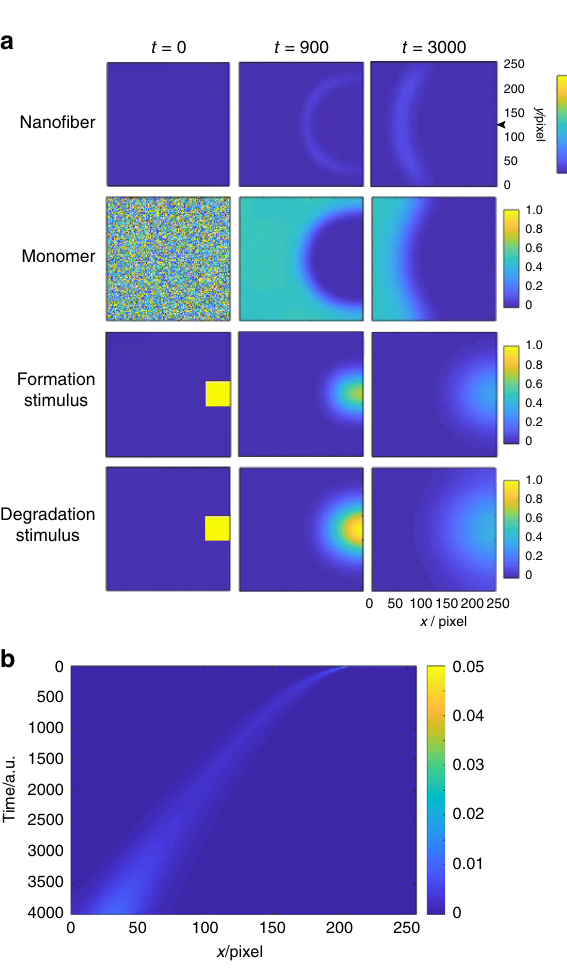
Fig. 3 Numerical simulation of the propagating wave based on a reaction- diffusion mechanism. a Time dependent concentration changes of (top) supramolecular nano fi bers, (2nd row) monomer, (3rd row) formation, and (bottom) degradation stimuli. Please see the main text and SI for the reaction-diffusion equations. b Kymograph of the nano fi ber concentration on the center at y axis ( y = 128, highlighted by a black arrowhead) of Fig. 3a. Condition: D n : 0.0001, D m : 0.003, D x : 0.003, D y : 0.006, k 1 : 0.1, k 2